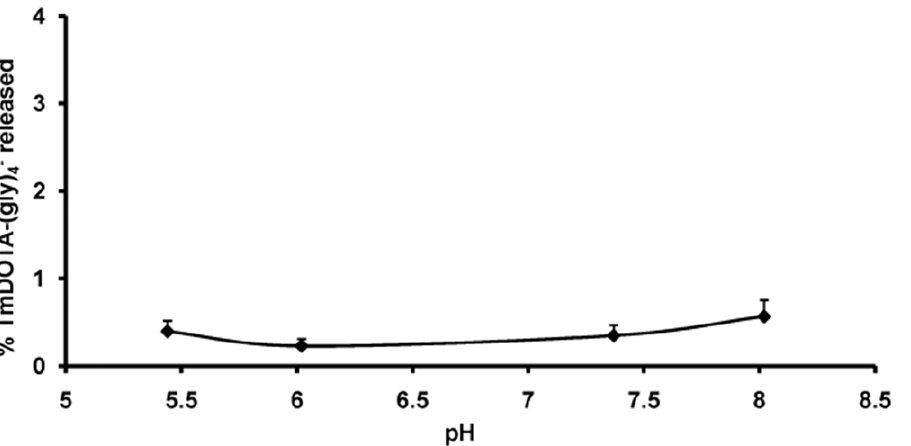
Figure 6. Invitro stability of a liposomal suspension at different pH values (n=2). TmDOTA-(gly) 4 2 was measured analytically in the extraliposomal medium after incubation of liposomes at 298 K for 24 hr at several different pH values.